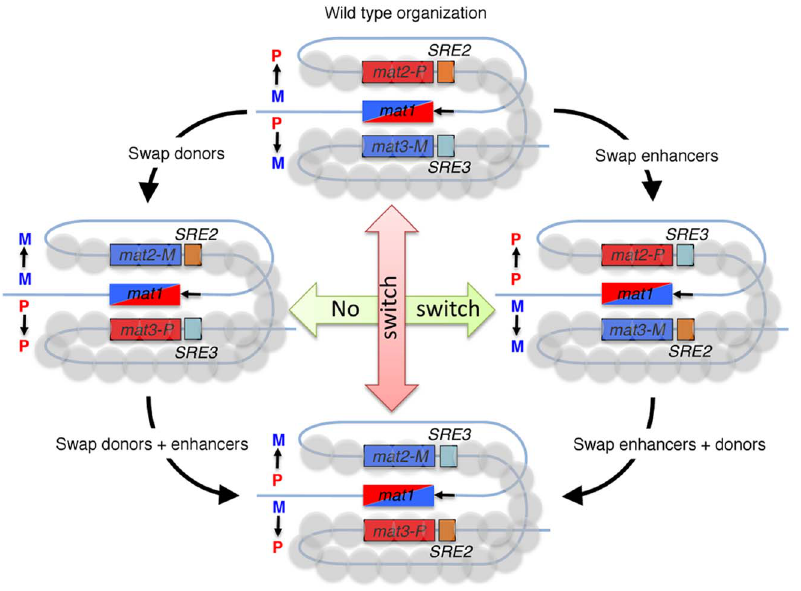
Figure 1. Fission yeast cells switch mating-type in a directional manner, by gene conversions of the mat1 locus. A recombinogenic DNA end is formed at mat1 during DNA replication (black arrow) and the broken DNA invades a donor whose genetic information is copied into mat1 . Wild-type M cells ( mat1-M allele) use the mat2-P donor, while P cells ( mat1-P allele) use the mat3-M donor, as depicted in the top drawing. The recombination enhancers SRE2 and SRE3 are central to these choices. Experiments in which donors and enhancers are swapped, alone or in combination, show that SRE2 and SRE3 are recognized in a cell-type specific manner to promote use of their adjacent donor. The heterochromatic structure of the mat2-P–mat3-M region is required for this differential